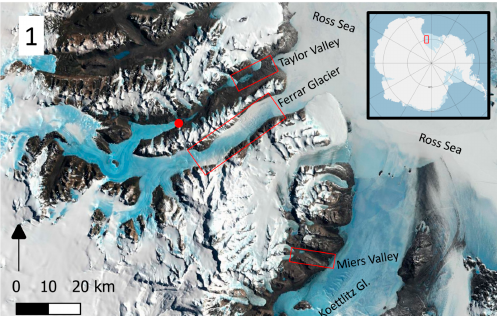
Figure 1. The McMurdo Dry Valleys Region Landsat Image of Antarctica (LIMA) high-resolution virtual mosaic [43]. The red dot denotes the location of Blood Falls at the terminus of Taylor Glacier. Inset shows the study region (red box) on a map of Antarctica. An airborne electromagnetic (AEM) survey was flown in the MDV region in November 2018 using the SkyTEM312 system, as a follow up to a proof-of-concept 2011 AEM survey [28,39,44]. The SkyTEM312 system is an airborne transient-electromagnetic (TEM) sensor and consists of a rigid frame approximately 20 by 30 m in dimension on which the various system components are mounted. The entire system is suspended and flown beneath a helicopter allowing efficient data collection over extensive regions. It employs a dual moment transmitter with an area of 342 m 2 . For the low-moment, the transmitter coil has 2 turns, a peak current of ~6 amps (A), and a repetition frequency of 210 hertz (Hz). For the high-moment, the transmitter coil has 12 turns, a peak current of ~110 A, and a repetition frequency of 30 Hz. The use of a dual moment transmitter balances high-resolution in the shallow subsurface with large depth penetration [45], where the subsurface can be imaged to depths up to ~600–700 m in certain conditions, such as when a conductive aquifer underlies resistive materials like frozen ground or glaciers. The AEM system flown in 2018 has significant improvements over the 2011 system including larger transmit moments and a receiver with improved sensitivity. Together these advances translate to an improved depth penetration/resolution, as well as an aerodynamic frame capable of achieving greater flying speeds of ~80–110 km/h. The collected low and high-moment data presented here included time gates from 26 μ s to 1.39 ms and 392 μ s to 10.7 ms, respectively. TEM measurement involves energizing a transmit loop (i.e., ramping a current up to a peak value) and then ramping down the current in the transmit loop as rapidly as possible. When ramping the current down, a time-varying magnetic field is produced in the subsurface which induces eddy currents that propagate downwards and outwards away from the sensor. These eddy currents in turn generate a secondary magnetic field. The time variation of the secondary magnetic field is measured using a receiver coil mounted on the frame flown beneath the helicopter. The decaying secondary magnetic field produces decaying voltage signals. Further details concerning the TEM method are in Chapter 6 of Kirsch. The result of an AEM survey is a data volume consisting of suites of measured EM field decay curves collected along densely sampled profiles. The raw data are used to constrain inverse models